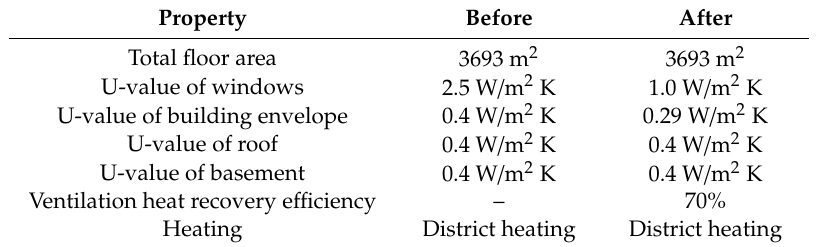
Table 2. Properties a ff ecting energy consumption and values before the retrofit and after the retrofit. Property Before